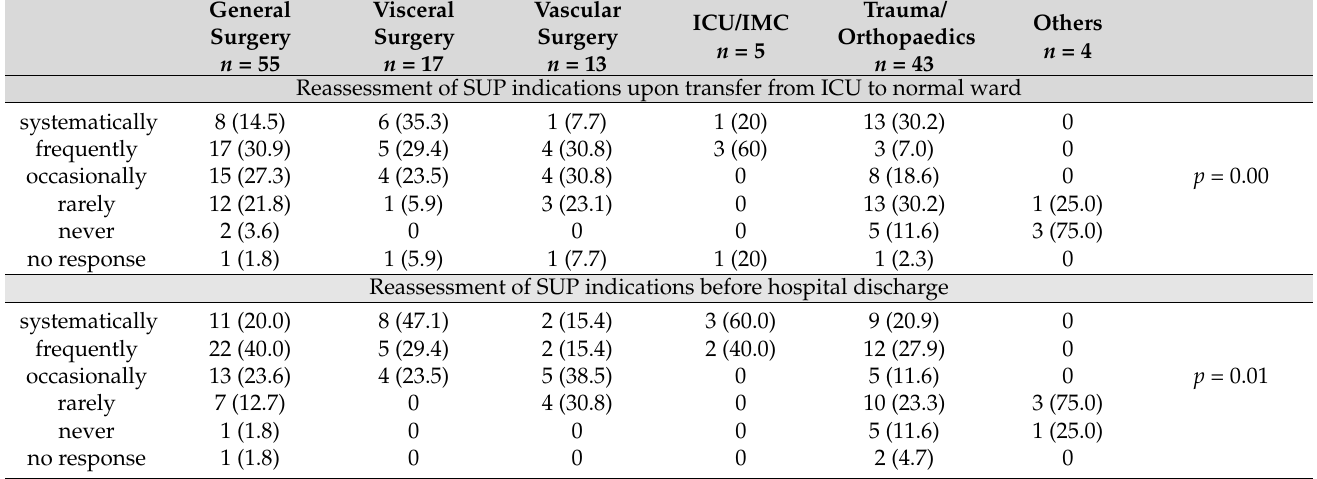
Figure 2. Routine practice of SUP according to MSMs. MSM staff members were asked whether, in their personal daily practice, SUP indication was systematically reassessed on the occasion of the transfer from the ICU/ICM to the GHWs ( A ) and before the discharge of the patient from the hospital ( B ). ( n = 137). Table 5. Routine practice of SUP according to MSMs. MSMs were asked whether, in their personal daily practice, SUP indication was systematically reassessed on transfer from the ICU/ICM to the GHWs and before the discharge of the patient from the hospital. Results are classified according to the leading professional activity of the respondents ( n =